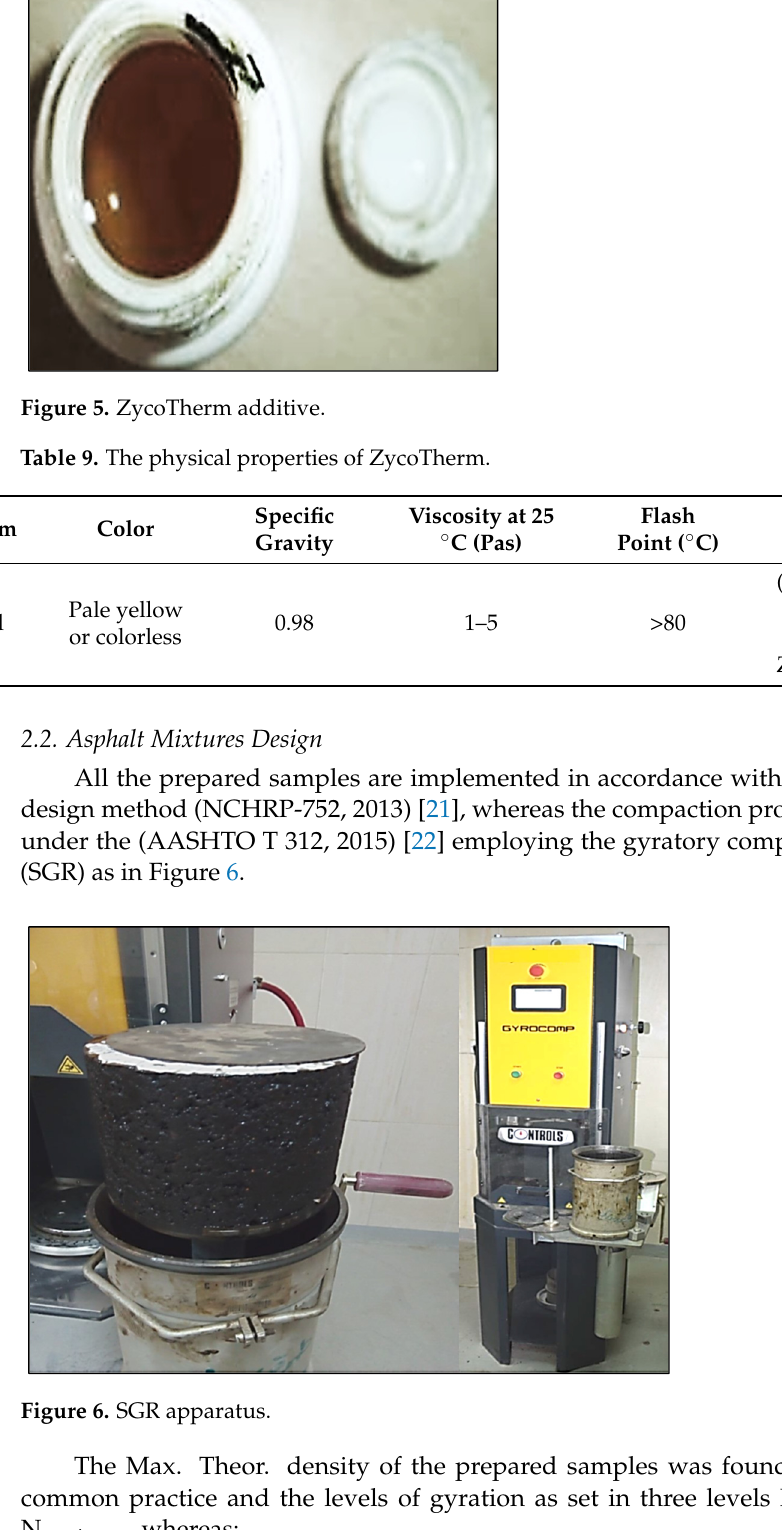
Table 9. The physical properties of ZycoTherm.